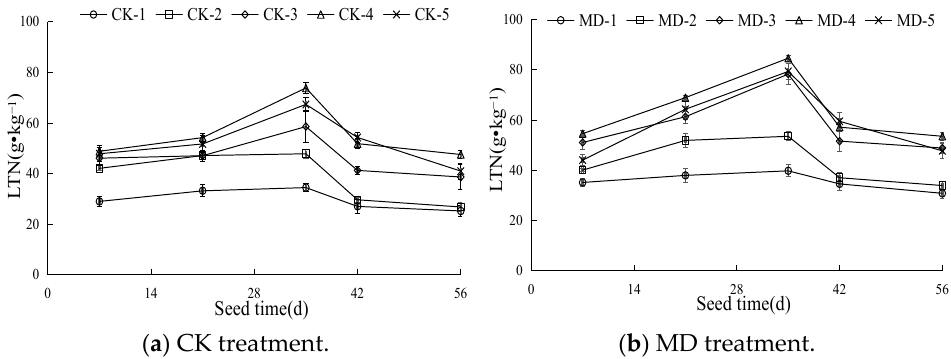
Figure 1. Dynamic changes in leaf total nitrogen under different treatments. CK-1, CK-2, CK-3, CK-4, and CK-5 indicate that the soil moisture content is controlled at 45–55%, 55–65%, 65–75%, 75–85%, and 85–95% of the field capacity with conventional water, respectively; MD-1, MD-2, MD-3, MD-4, and MD-5 indicate that the soil moisture content is controlled at 45–55%, 55–65%, 65–75%, 75–85%, and 85–95% of the field capacity with magnetoelectric water, respectively.LTN, leaf total nitrogen.